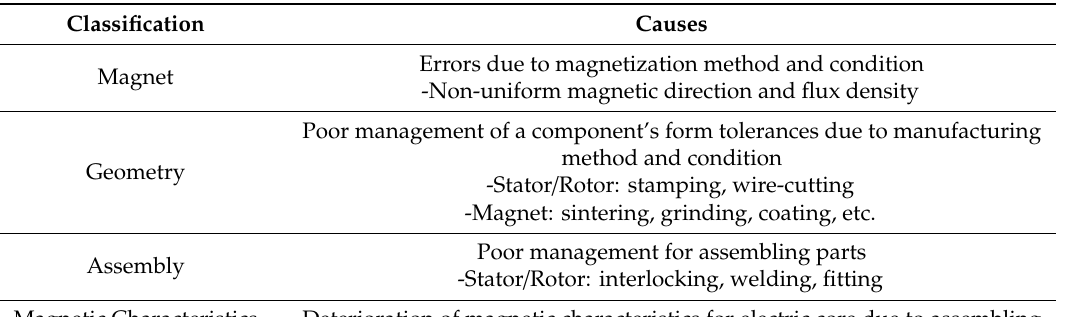
Table 3. Classification and causes of manufacturing tolerances in a